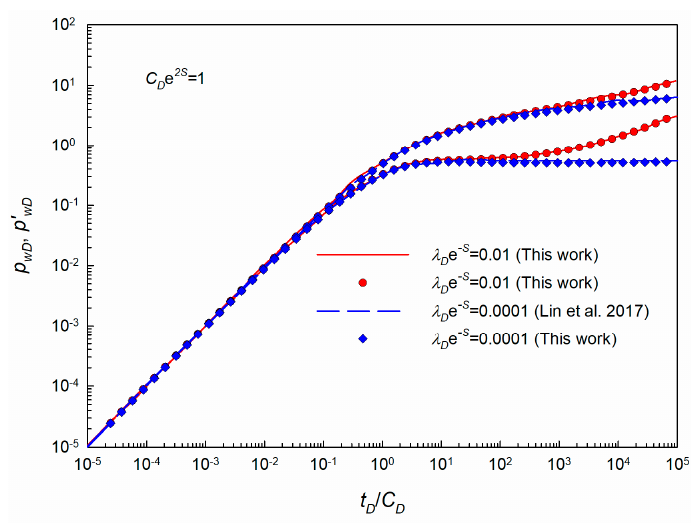
Figure 5. Comparison of transient pressure response obtained from this work and those from literature [26] for a vertical well in a tight formation with consideration of TPG.